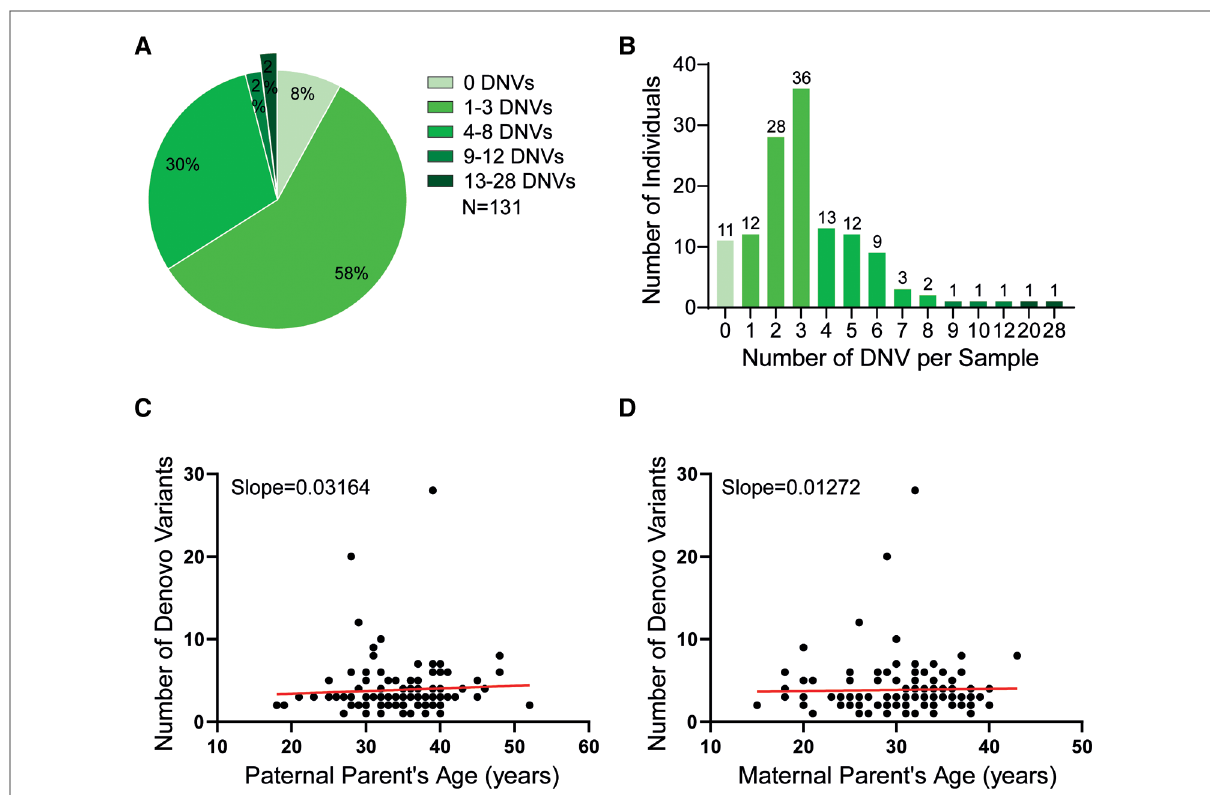
FIGURE 1 ( A ) The pie chart depicts the number distribution of the de novo variants (DNVs) that were identi fi ed in our cohort ( B ) The bar plot depicts the number of de novo variants in the exomes per sample. ( C ) The dot plot shows the correlation between the paternal age and the de novo variants (DNV) frequency in his offspring. Each dot de fi nes the numbers of DNV ( y -axis) in relation to the age of the respective fathers ( x -axis) when their children were born. Linear regression analysis de fi nes a best- fi t line with an intercept of 2.7854 and a slope of 0.03164 that veri fi es a positive correlation between these two parameters. ( D ) The dot plot shows the correlation between the maternal age and the DNV frequency in her offspring. Each dot de fi nes the numbers of DNV ( y -axis) in relation to the age of the respective mothers ( x -axis) when their children were born. Linear regression analysis de fi nes a best- fi t line with an intercept of 3.49049 and slope of 0.01272 that veri fi es a positive correlation between these two